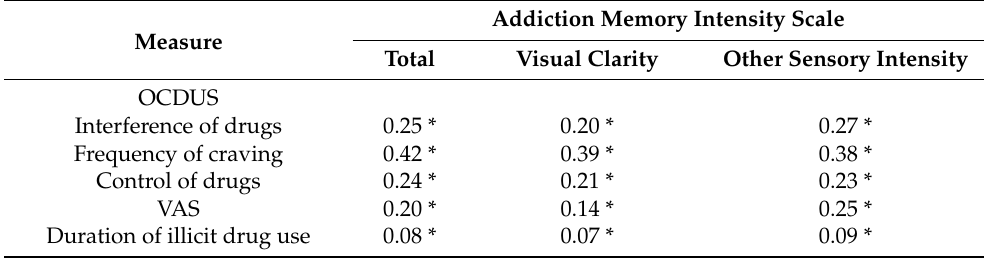
Table 5. Correlations between the Addiction Memory Intensity Scale and other measures ( n =